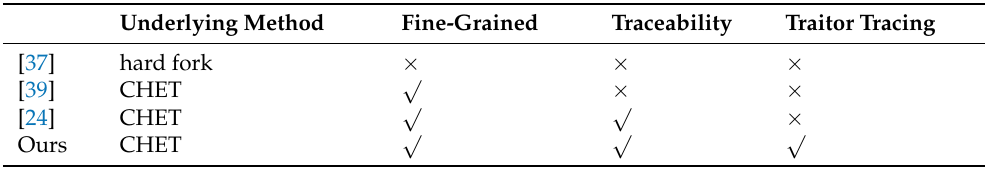
Table 2. Comparison of mutable blockchain